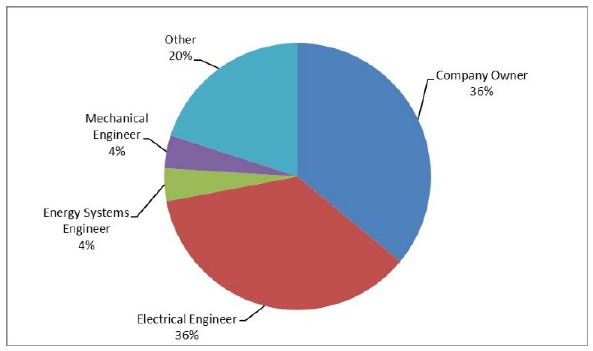
Figure 8. “Evaluation of Solar Power Plant Location Selection Impact Factors” Survey Participants and Distribution of Title